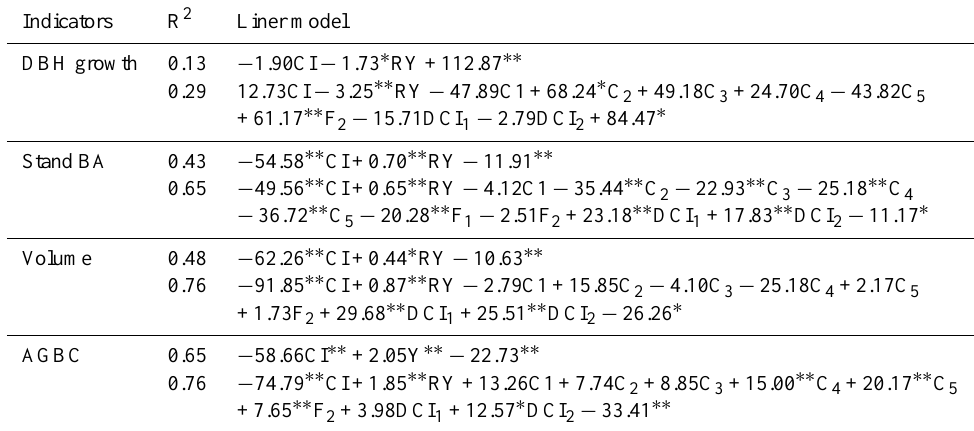
Table 3. General linear models of potential driving factors predicting the relative changes (%) for the four variables with sufficient observa- tions ( P < 0 .